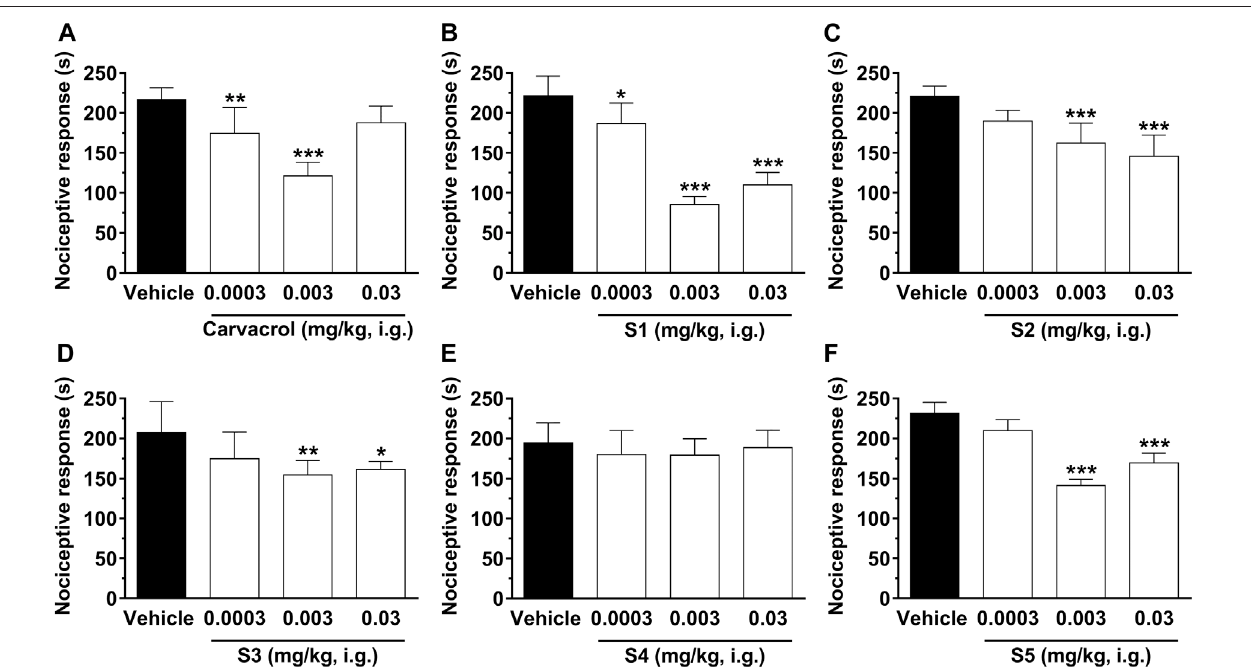
FIGURE4| Effectofcompoundsonnociceptioninducedbyglutamate(i.pl.)inmice.Thepainbehavior,translatedbythenociceptiveresponseoflicking/bitinghind pawsinducedbyglutamate(i.pl.),wasevaluated1houraftertreatmentwithcarvacrol (A) , S1(B) , S2(C) , S3(D) , S4(E) and S5(F) atdosesrangingfrom0.0003,0.003, and 0.03 mg/kg, i.g., (open bars) or vehicle/control (closed bar). Each bar denotes the average response for 6 – 8 animals, and the vertical lines represent the SEM (standard error of mean). Asterisks (*) indicate the signi fi cance in comparison with the control group animals (* p < 0.05, ** p < 0.01, and *** p < 0.001). One-way ANOVA and Dunnett test for multiple comparisons were used to determine the statistical signi fi cance.